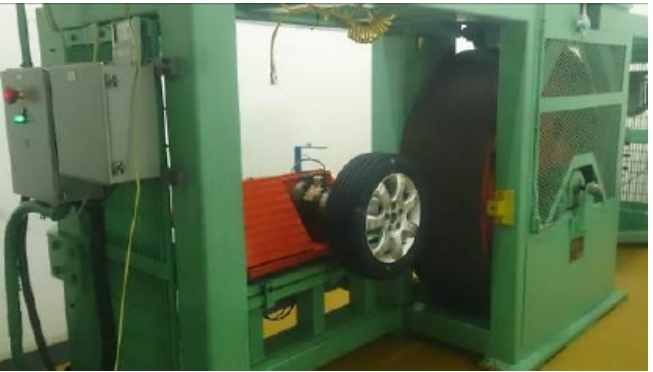
Figure 14. Tire drum testing machine.